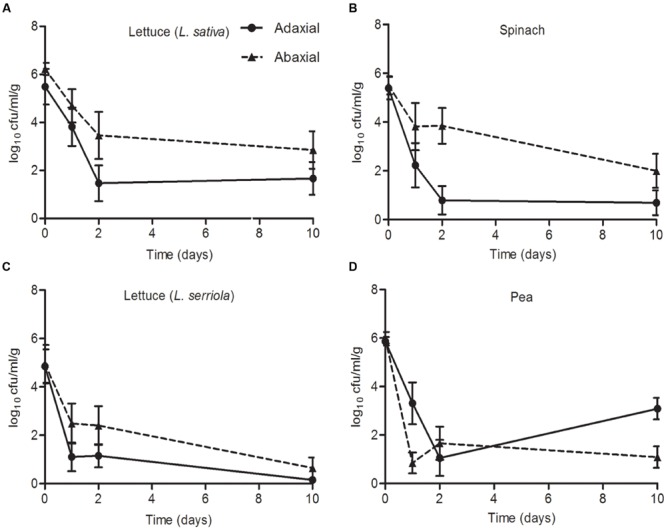
Escherichia coli O157:H7 (Sakai) on leaves. The numbers of E. coli O157:H7 (Sakai) recovered from the leaves of roundhead lettuce [L. sativa; A), spinach (Spinacia oleracea; B), wild prickly lettuce (Lactuca serriola; C), and vining green pea (Pisum sativum; D], following inoculation of the abaxial (black triangles) or adaxial (black circles) surfaces with a starting inoculum of 2 × 106 CFU (Log10 6.3). The average and the standard error of the mean for six replicates for each of the time points is expressed as the number of CFU recovered per gram of fresh tissue (Log10). Data is generated from nine replicate samples and was analyzed by one-way ANOVA with the Tukey multiple comparison test.